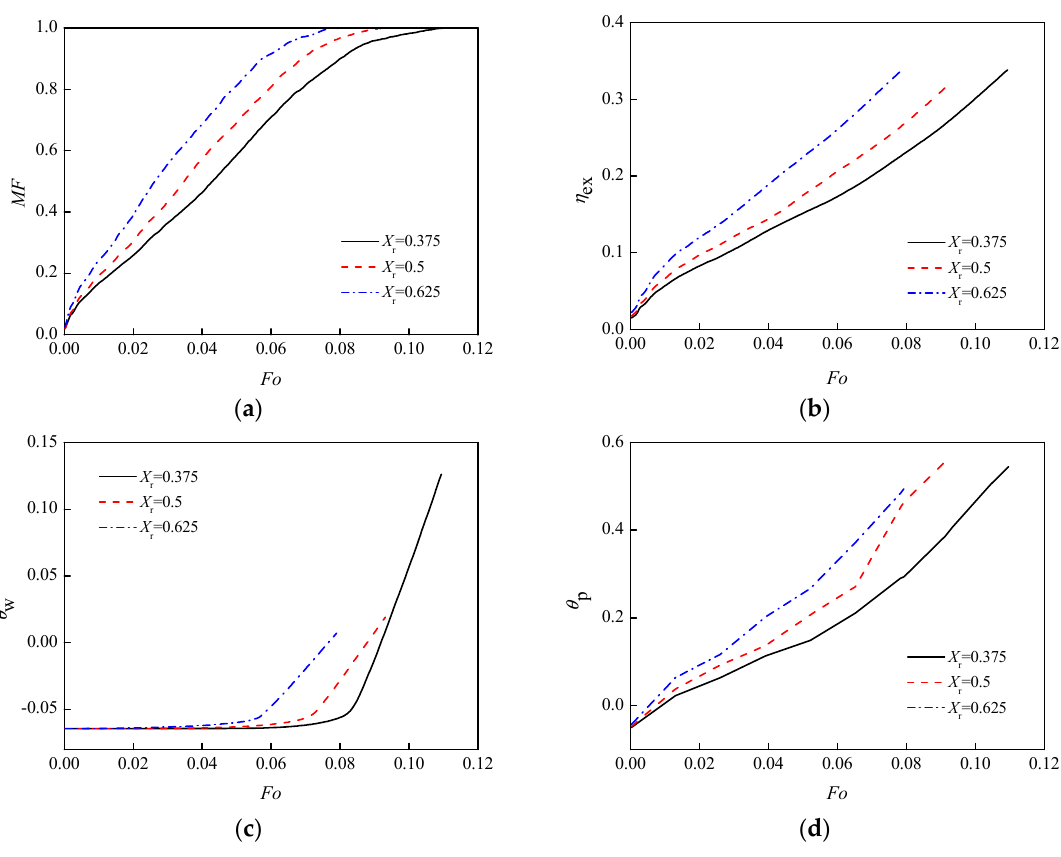
Figure 7. Evolution of the performance parameters for varying inner tube diameter: ( a ) melting fraction; ( b ) exergy efficiency; ( c ) water temperature; ( d ) paraffin temperature.